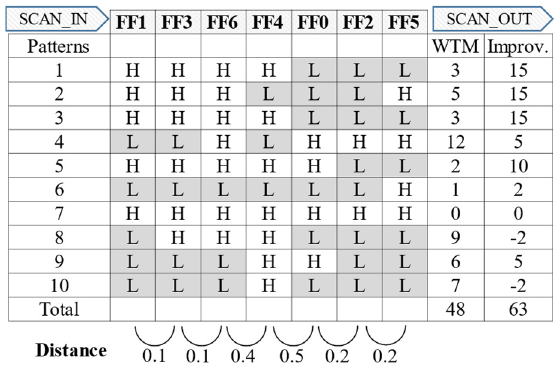
Figure 10. WTM of example response vector with the proposed method.